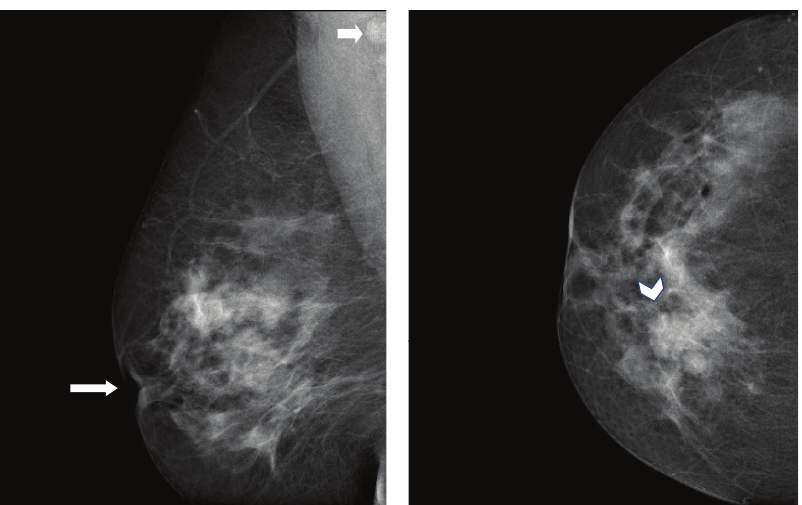
Figure 1: MLO and CC views of right breast. Biopsy proven granulomatous mastitis. There is an area of architectural distortion in the upper inner aspect of right breast with slightly nodular configuration and clear nipple retraction. These findings are classical for malignancy. A small rounded lymph node can be seen in axilla on MLO view.